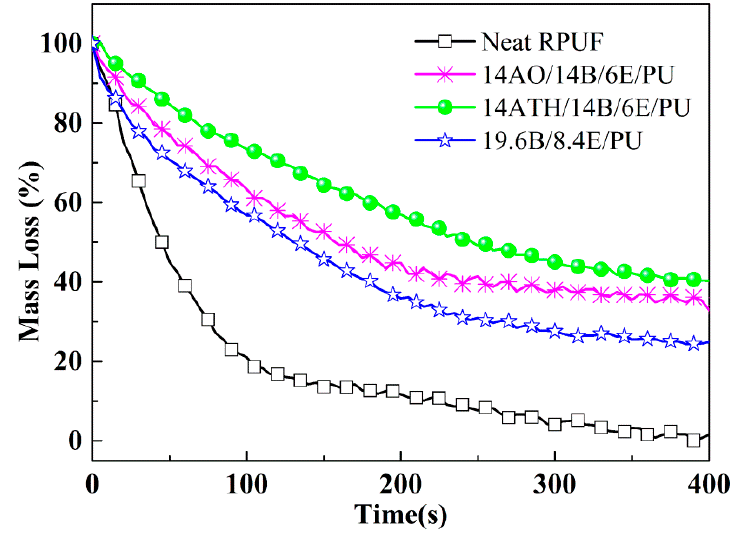
Figure 2. Mass loss curves of RPUFs.